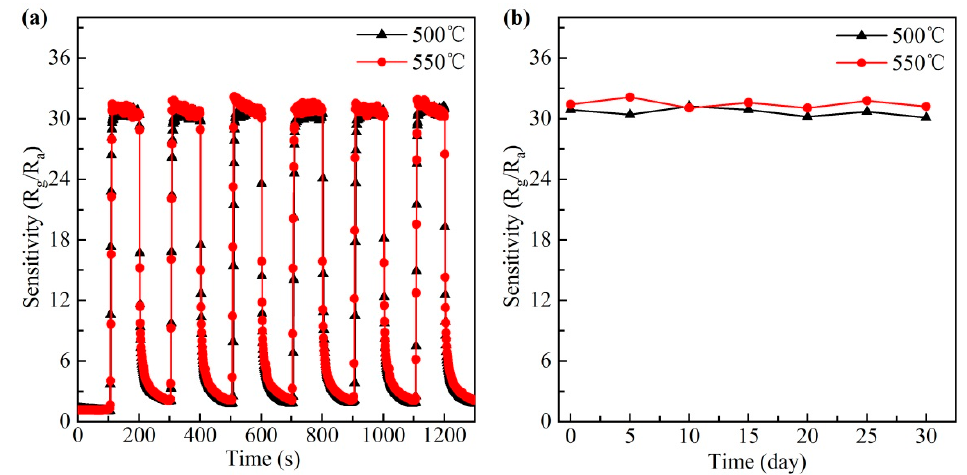
Figure 6. ( a ) Reversibility and ( b ) long-term stability of two BiFeO 3 sensors to 100 ppm isopropanol at 240 °C.